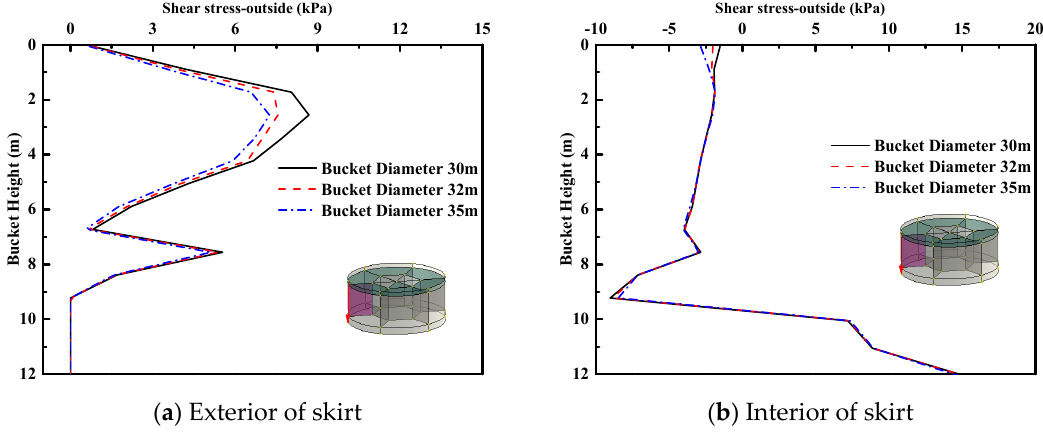
Figure 19. Shear stress of skirt under different bucket diameter.